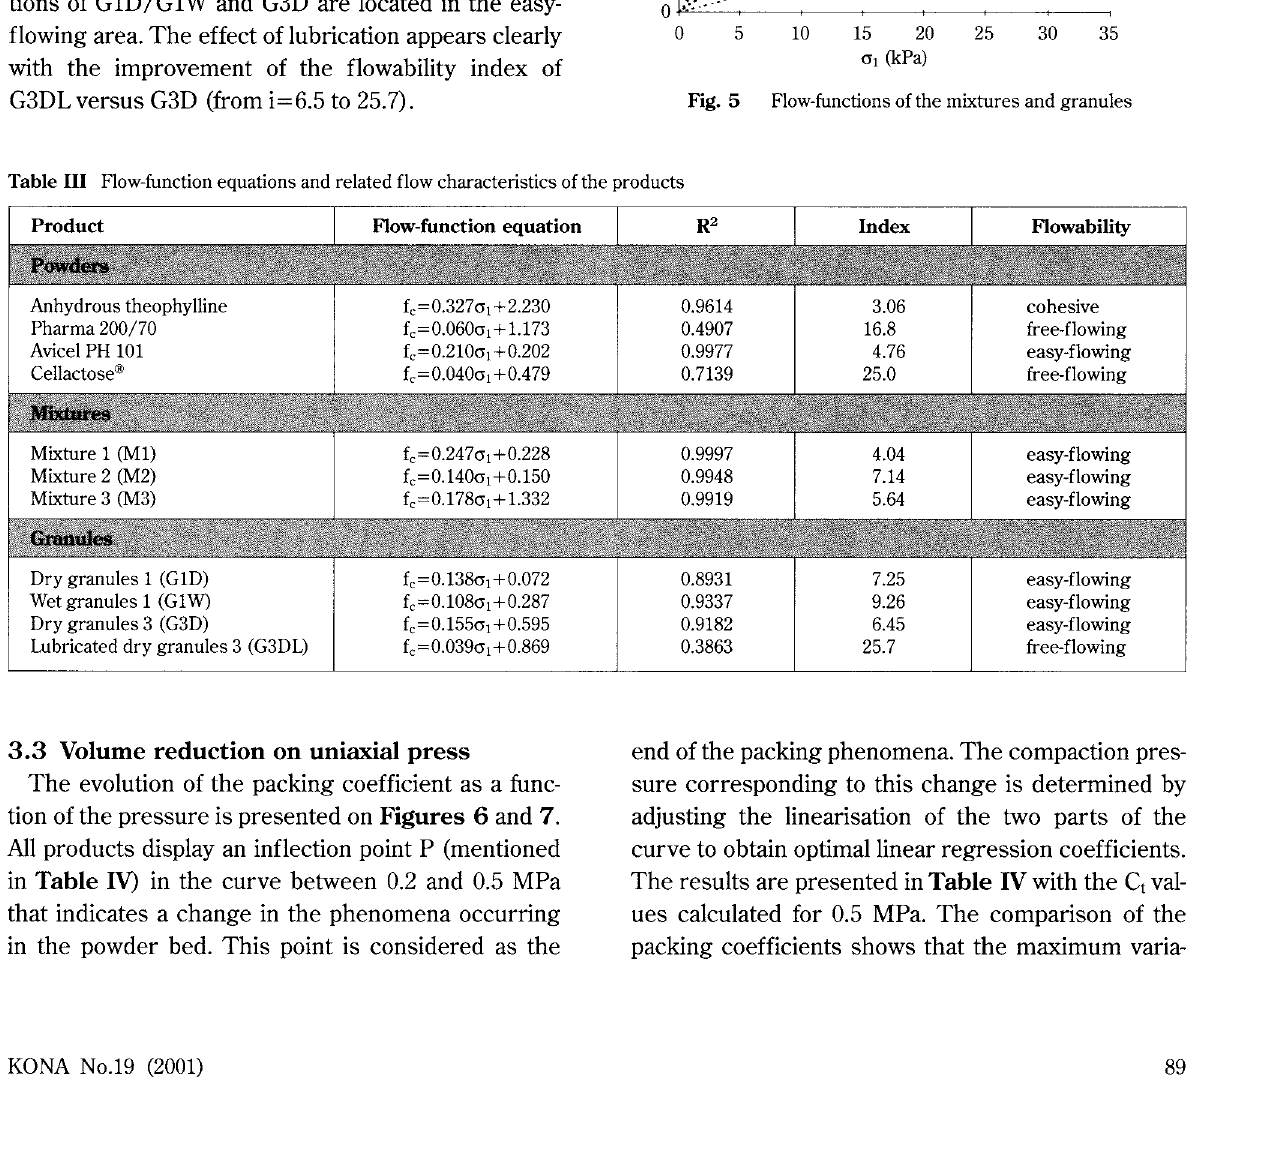
Table III Flow-function equations and related flow characteristics of the products